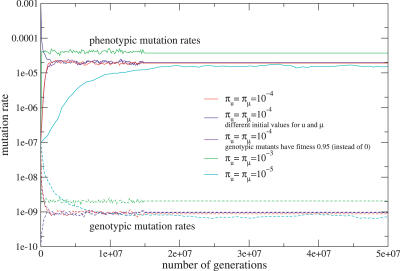
Evolution of Genotypic and Phenotypic Mutation Rates with Different Simulation Parameters (see the section Effect of Initial Values and Parameters on the Simulation Results)For all five parameter combinations, we use c = 10−11. Most simulations reach equilibrium within 1.5 × 107 generations. For πu = πμ = 10−5, it was necessary to extend the simulations to 5 × 107 generations. For simulations that end after 1.5 × 107 generations, we plot straight lines thereafter. These lines serve as visual cues and are at the level of the last value.